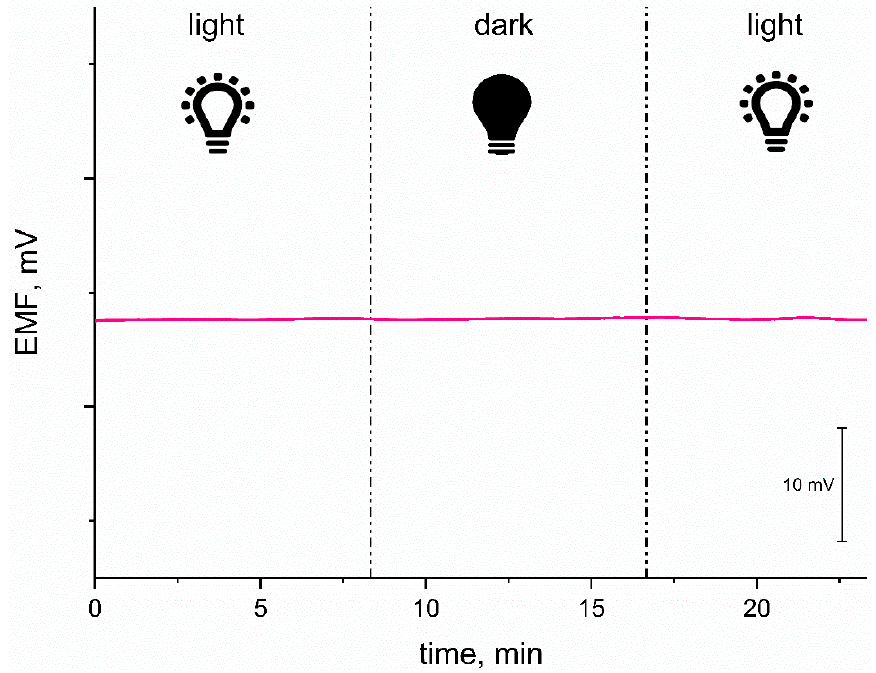
Figure 7. Potentiometric response of studied GC/RuO 2 + PEDOT:PSS/K + -ISM electrode (one electrode representing the group of solid-contact electrodes) showing its insensitivity to the light ex- position.